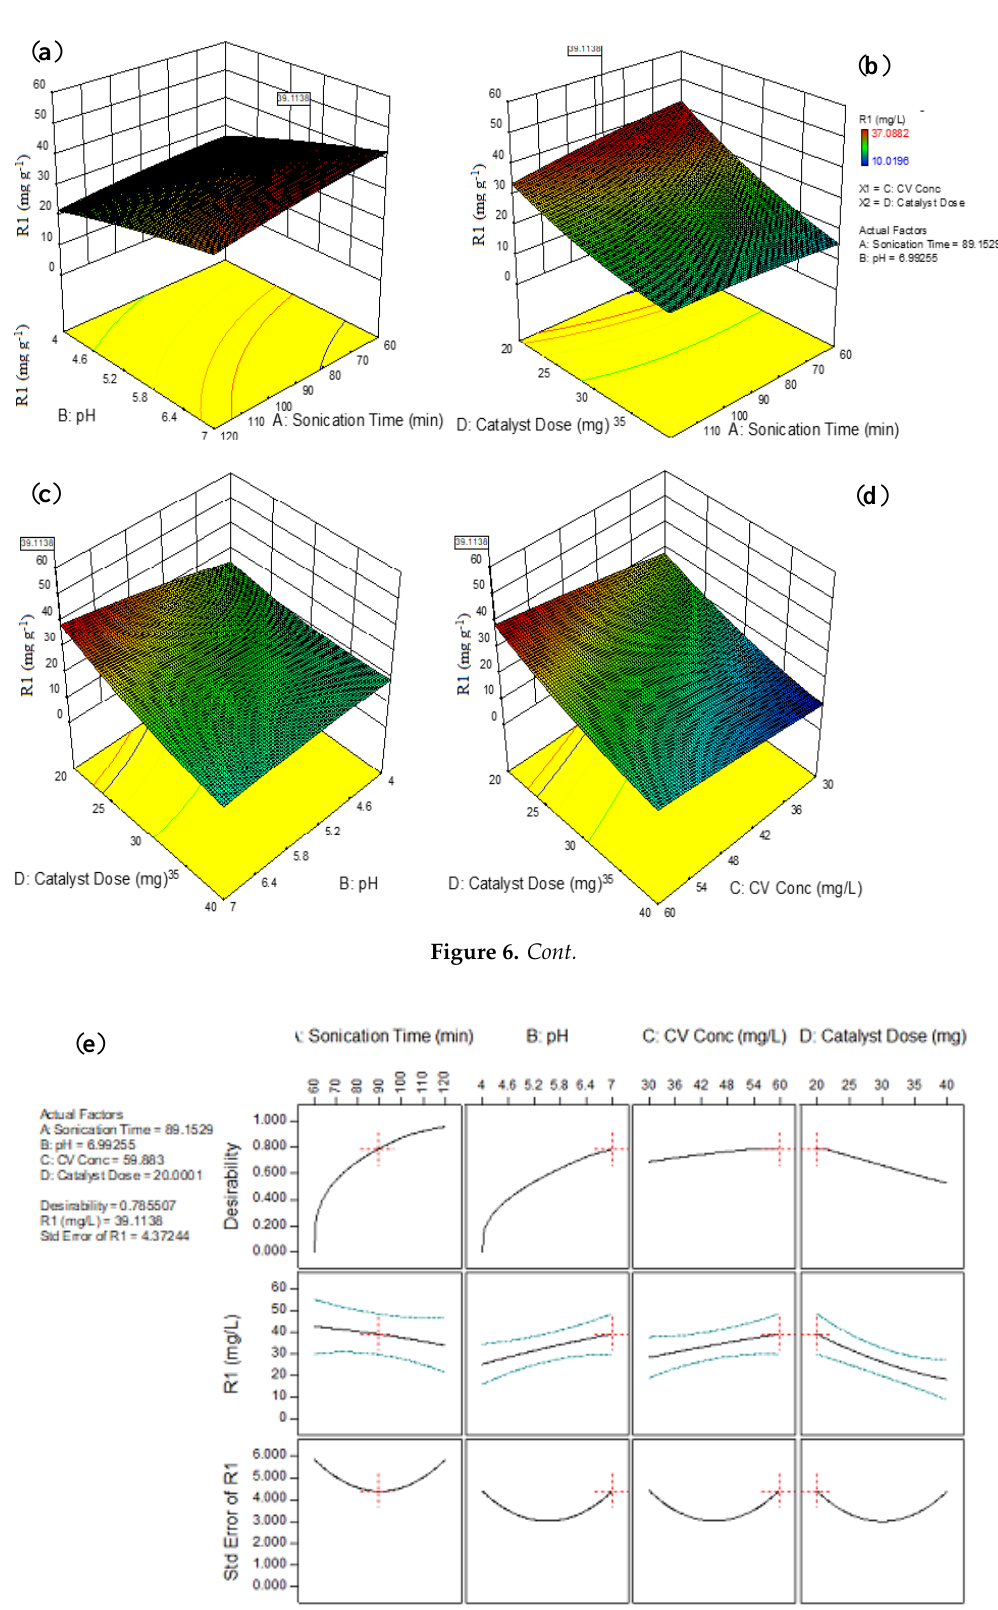
Figure 6. Three-dimensional surface interactive curves for ( a ) sonication time × pH of solution, ( b ) sonication time × adsorbent dose, ( c ) pH of solution × adsorbent dose and ( d ) CV concentration × catalyst dose. ( e ) Optimization plot for individual variable effecting the adsorption reaction.